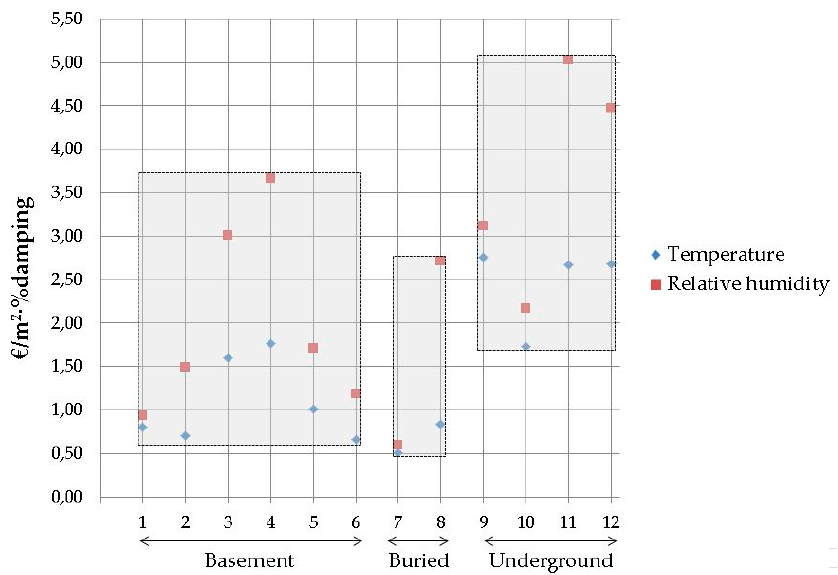
Figure 11. Correlation between cost and temperature and relative humidity.